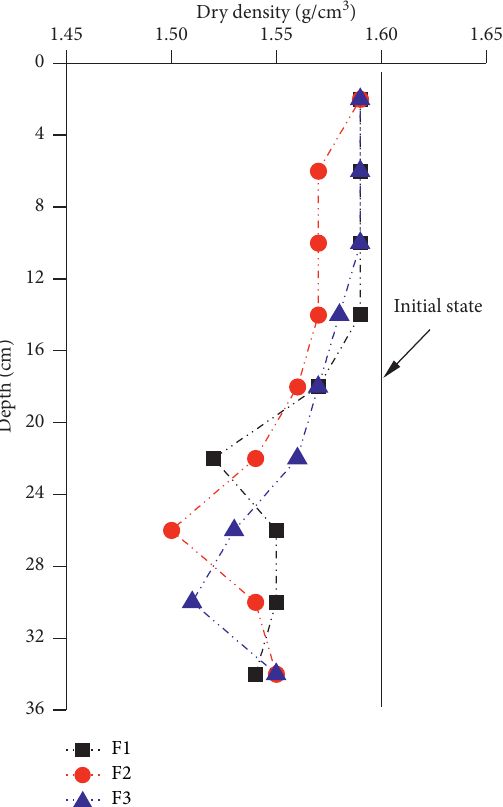
Figure 5: Dry density profiles of the expansive soil columns after the freeze-thaw process.